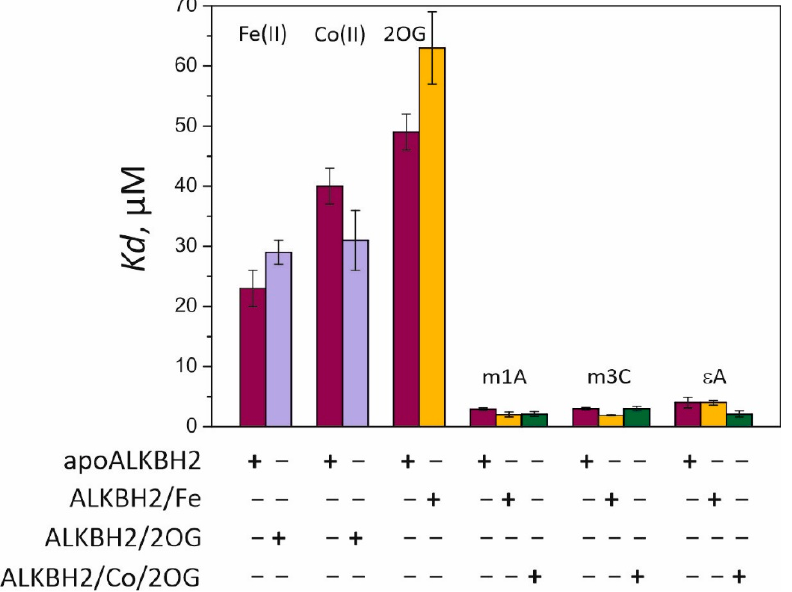
Figure 3. Analysis of ALKBH2 binding affinity by the equilibrium titration assay. The enzyme was titrated with metal ions (Fe(II) or Co(II)), 2OG, and methylated DNA at 25 °C. Dissociation constants ( K d ) were determined by the fitting of experimental data points to a quadratic binding equation (Equation (2); see Section 4.3). The efficiency of ligand binding to apoALKBH2 is presented as wine-colored bars. K d for the titration of preformed complexes ALKBH2/Fe, ALKBH2/2OG, and ALKBH2/Co/2OG is presented in lilac, yellow, and green colors, respectively. Error bars represent standard deviation of three technical replicates.